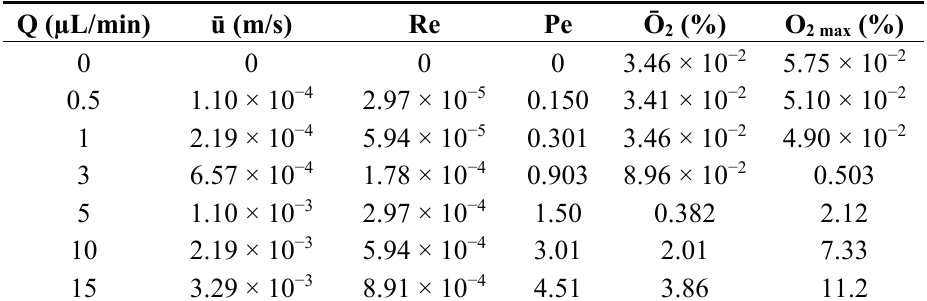
Table 1. Simulated average velocity ū in the channel middle, Reynolds number Re, Péclet number Pe, and the average ( Ō 2 ) and maximum (O 2 max ) oxygen level in the bottom of the cell-containing channel region for different volumetric liquid flow rates Q. All values determined from the results of the simulations presented in Figure